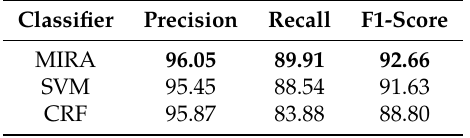
Table 10. Overall performance of each classifier.